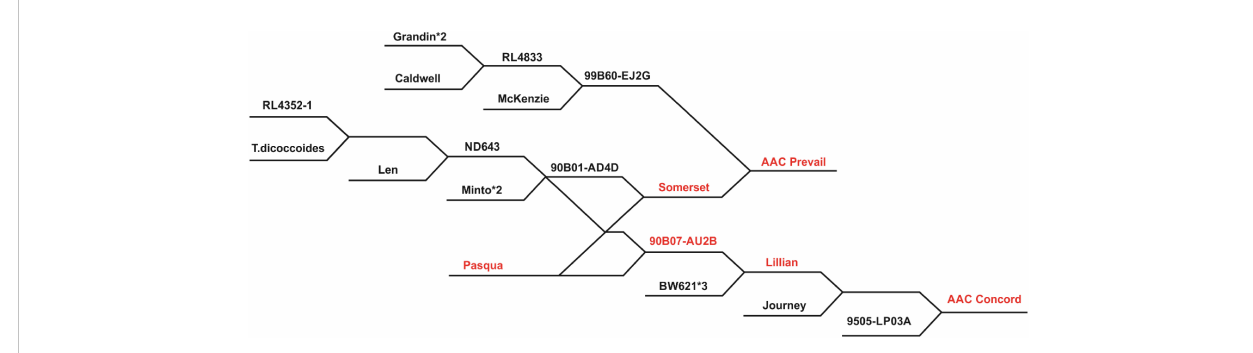
FIGURE 1 A dendrogram displaying Pasqua descendants Lillian, AAC Concord, and AAC Prevail. The asterisk sign “ * ” followed by numbers indicates how many times a recurrent parent was crossed with a line. RL4352-1 is a rust-resistant selection from cv. Columbus (Basnet et al., 2015). Pasqua descendants (red